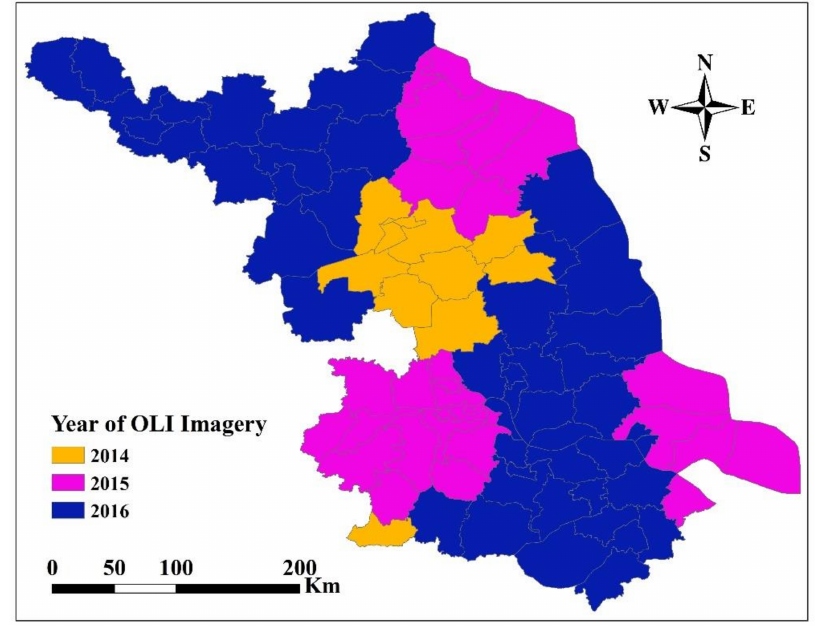
Figure 3. Year of Landsat OLI imagery used in this study. Table 2. A list of Landsat OLI images used in this